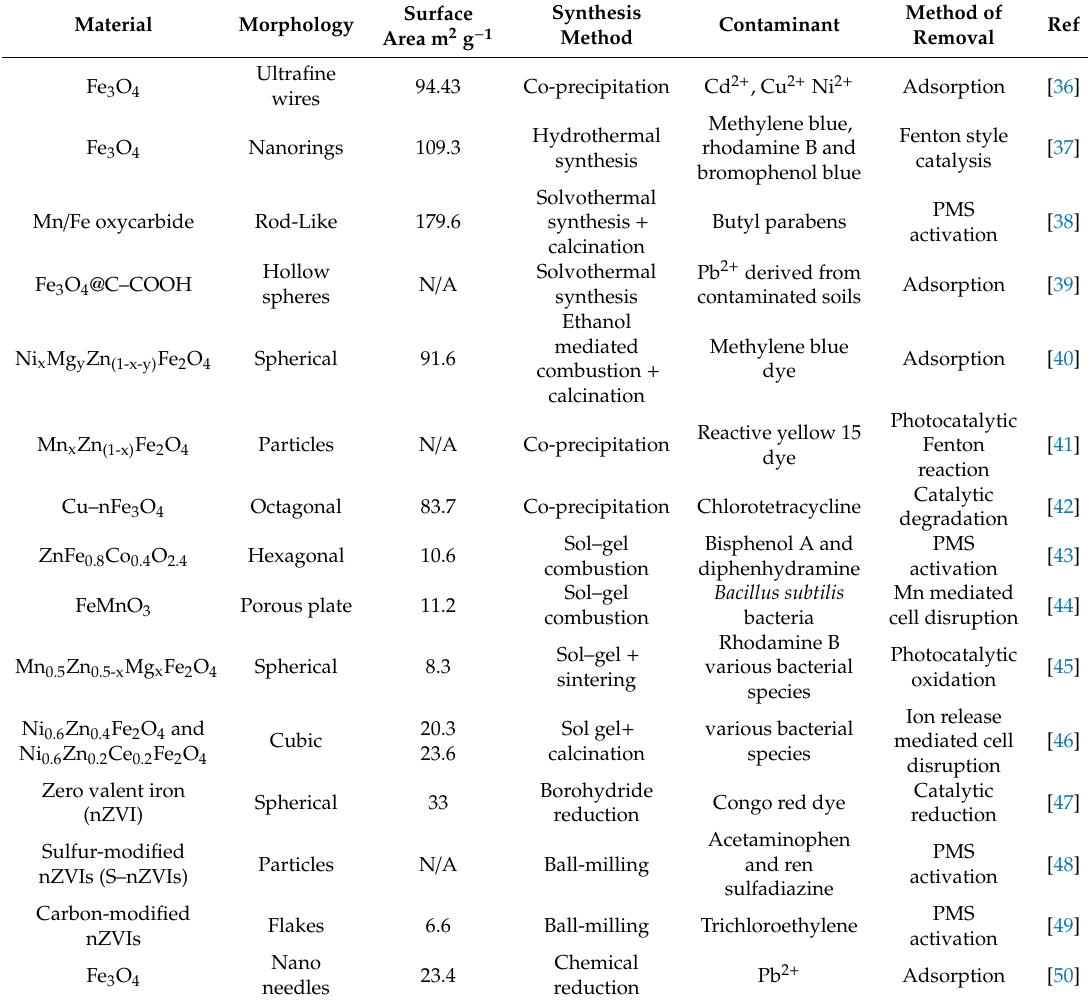
Table 2. Examples of distinctive single magnetic nanoparticles detailing their composition, structure, surface area, method for synthesis, contaminant examined and proposed method of removal of